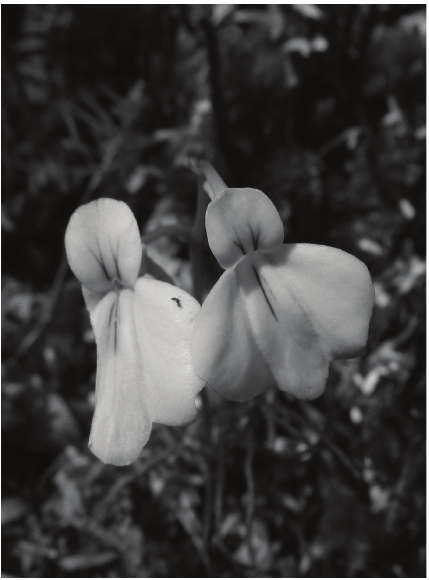
Figure 2: Utricularia vitellina— the endemic montane species of Peninsular